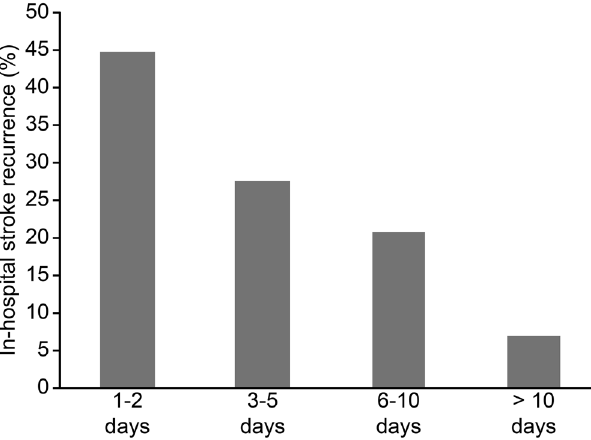
Figure 1. The time profile of in-hospital stroke